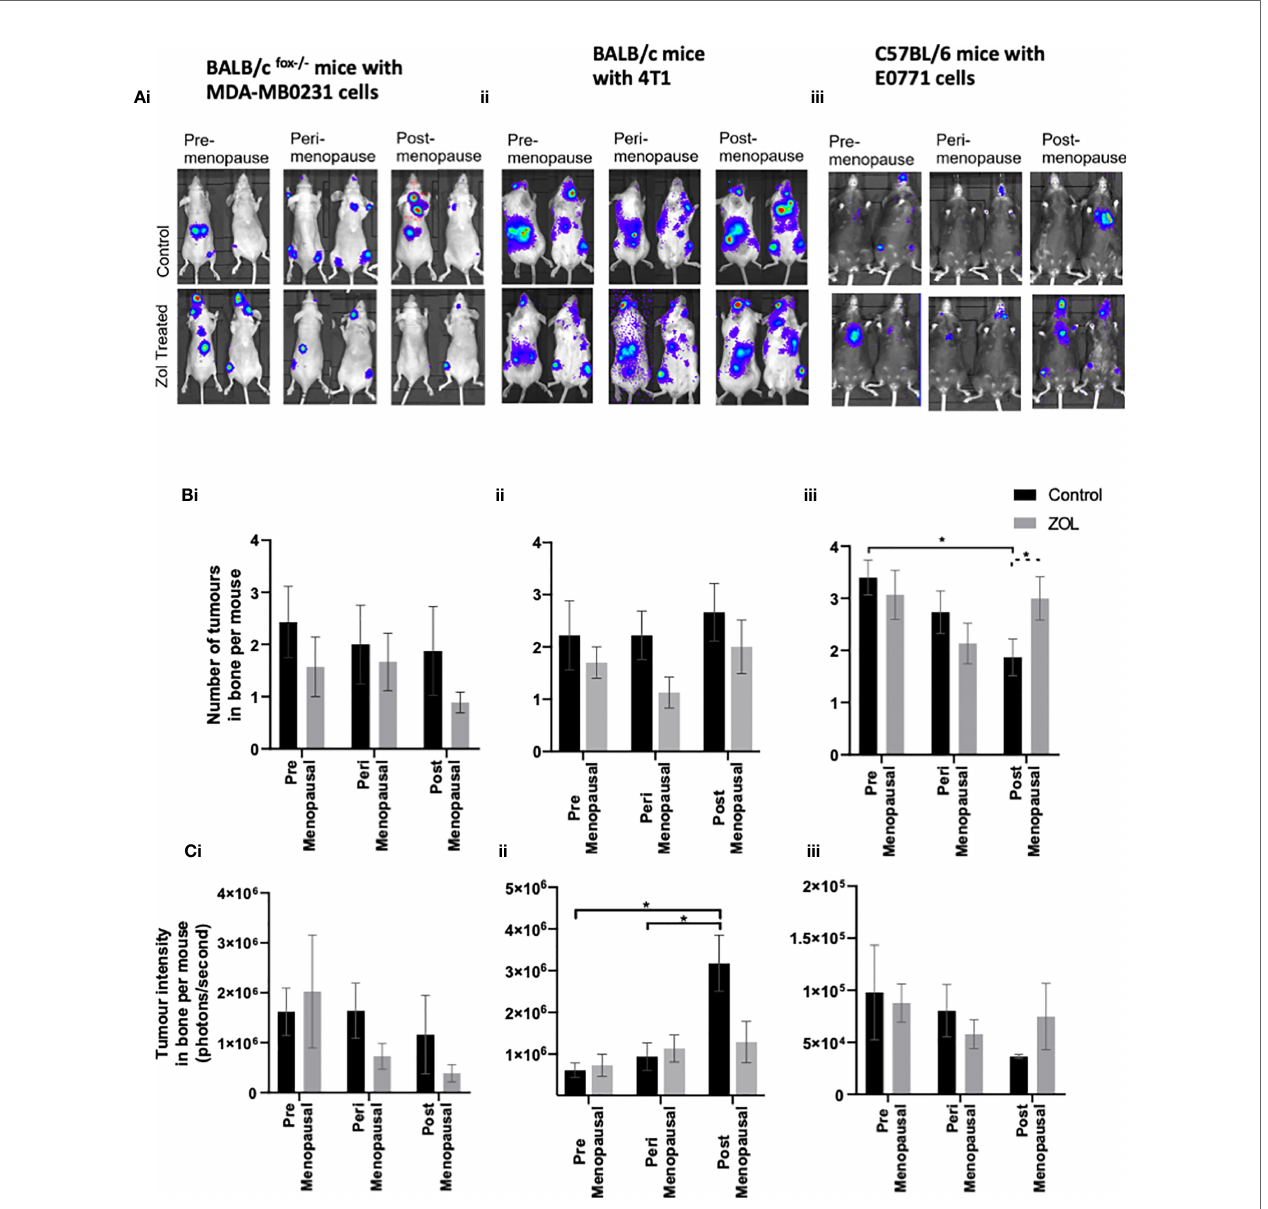
FIGURE 3 | Effects of pre-, post-, and peri-menopausal concentrations of oestradiol ± zoledronic acid on tumour growth in bone. Photographs show representative IVIS images of tumours growing in live animals (A) . Histograms show the numbers of overt metastases that form in the skeleton (B) and the bioluminescence signal in photons per second (P/S) from Luc2-expressing tumour cells in bone (C) in BALB/c fox/- mice injected with MDA-MB-231 cells (i), BALB/c mice injected with 4T1 cells (ii), and C57BL/6 mice injected with E0771 cells (iii) (n = 10/group). Cell lines were disseminated directly into the bloodstream of the mouse via intracardiac injection 3, 6, and 7 days after induction of pre-, peri-, or post-menopausal concentrations of oestradiol in BALB/c nude, BALB/c, and C57BL/6, respectively, and 3 days after fi rst injection of zoledronic acid. Zoledronic acid was administered weekly at a dose of 100 m g/kg, and all mice received daily injection of goserelin (40 m g/kg). All data on histograms are represented as mean ± SD; *p <